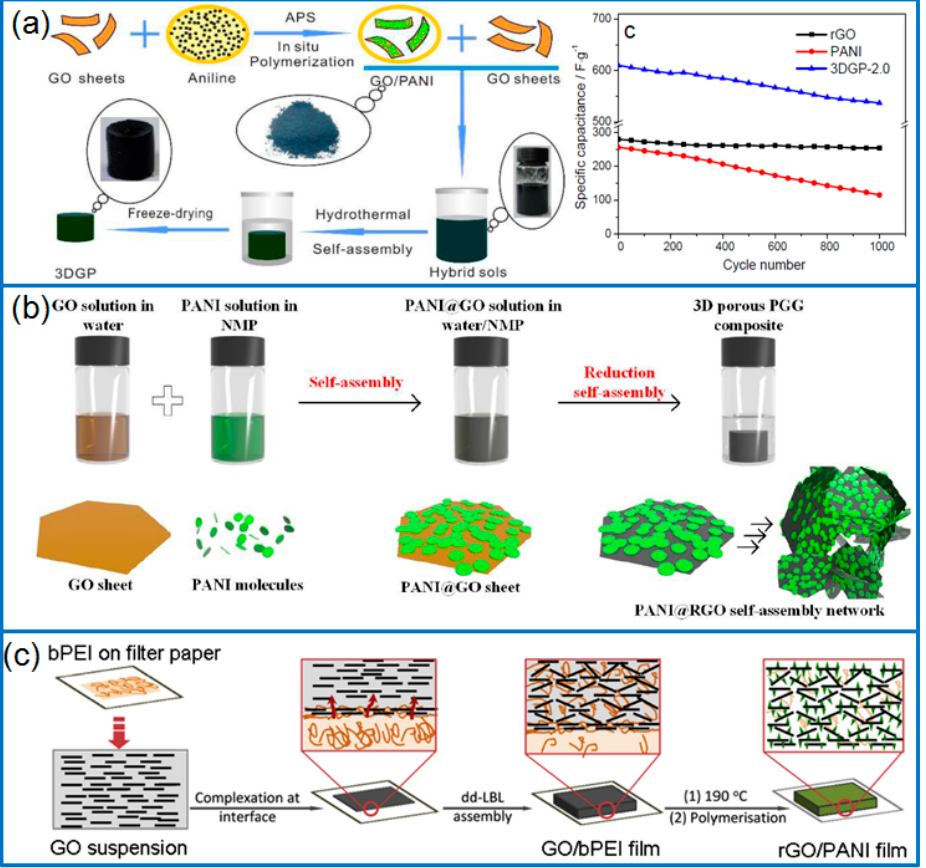
Figure 6. ( a ) Schematic for preparing PANI and 3DGP, and the cycling performance of di ff erent electrodes; produced with permission [88]. Copyright 2015, Royal Society of Chemistry. ( b ) Preparation of PANI@rGO network by self-assembly method; produced with permission [95]. Copyright 2018, Royal Society of Chemistry. ( c ) Schematic illustration for preparing rGO / PANI composite film by di ff usion driven layer-by-layer assembly; produced with permission [96]. Copyright 2017,